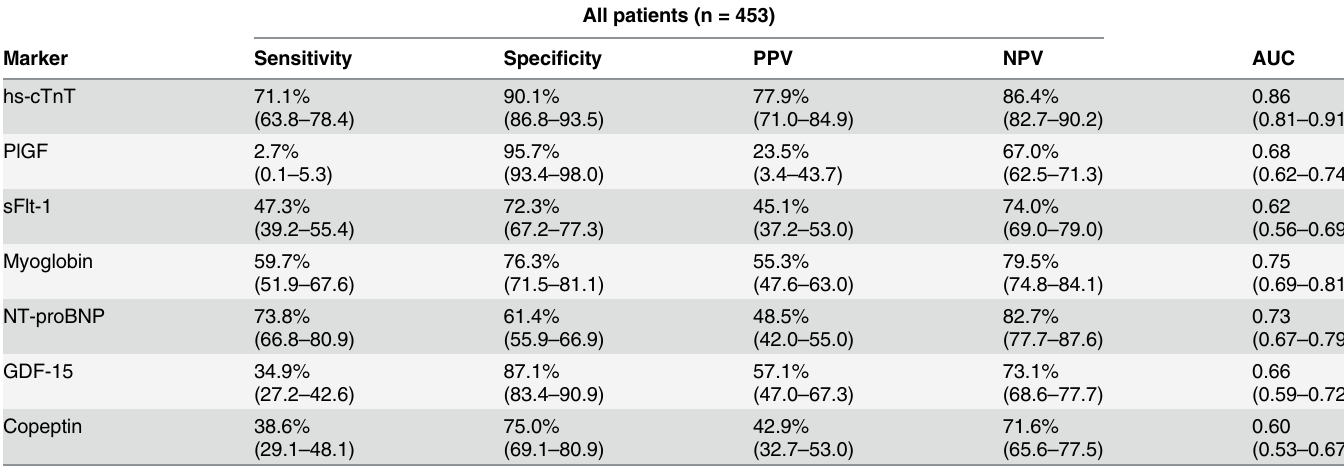
Table 3. Sensitivity, specificity, predictive values and AUCs of hs-cTnT, myoglobin and 5 novel biomarkers in all patients. All patients (n =